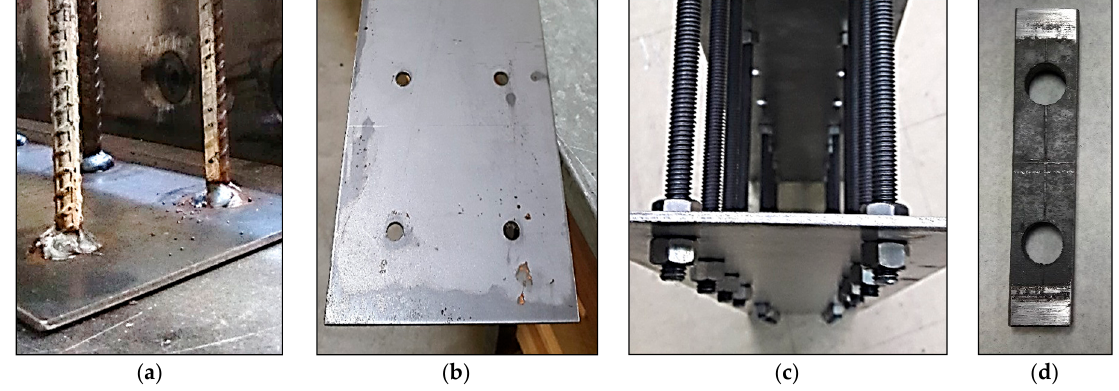
Figure 3. Shear connectors: ( a ) welded rebar, ( b ) punched steel plate, ( c ) bolted rods, and ( d ) rigid steel prism.